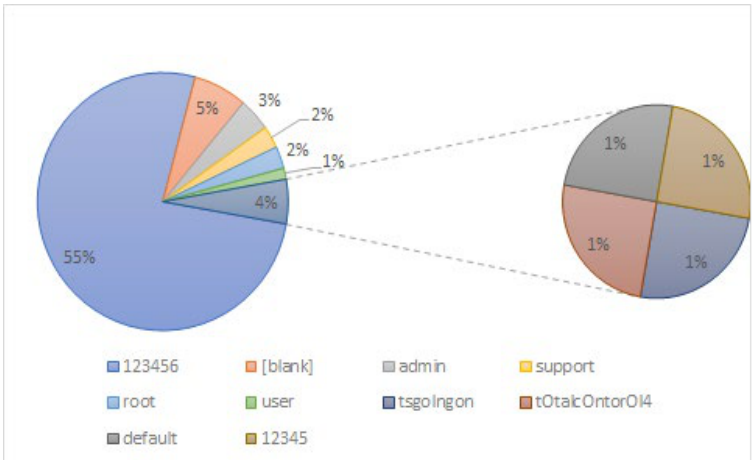
Figure 2. Top ten weak and default passwords in IoT attacks.